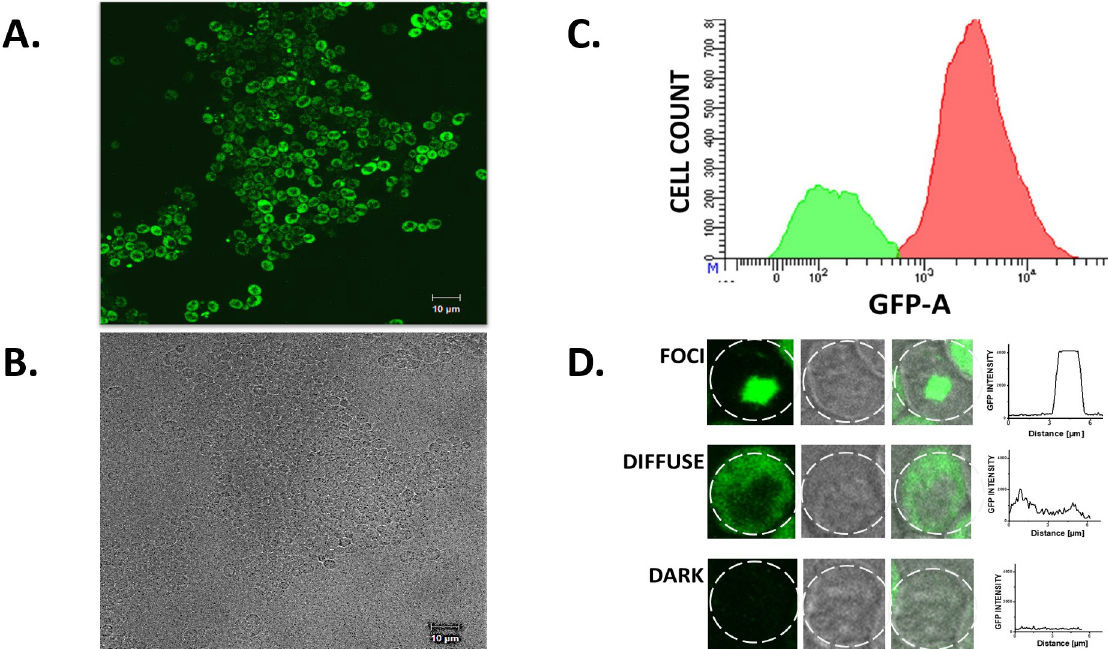
Fig 1. Characterization of wild type yeast cells expressing Sup35-GFP. (A) Wild type yeast cells expressing Sup35-GFP. (B) DIC image of (A). (C) Flow cytometry showing the percentage of fluorescent vs. dark cells in the population. 25% of the cells are dark. (D) Types of aggregation of Sup35-GFP in yeast cells. Three different aggregation phenotypes were observed: foci or aggregate (showing a fluorescent foci), diffuse (fluorescence observed throughout the cytoplasm), and dark (no fluorescence). GFP intensity versus distance plots show characteristic patterns for aggregate, diffuse, and dark